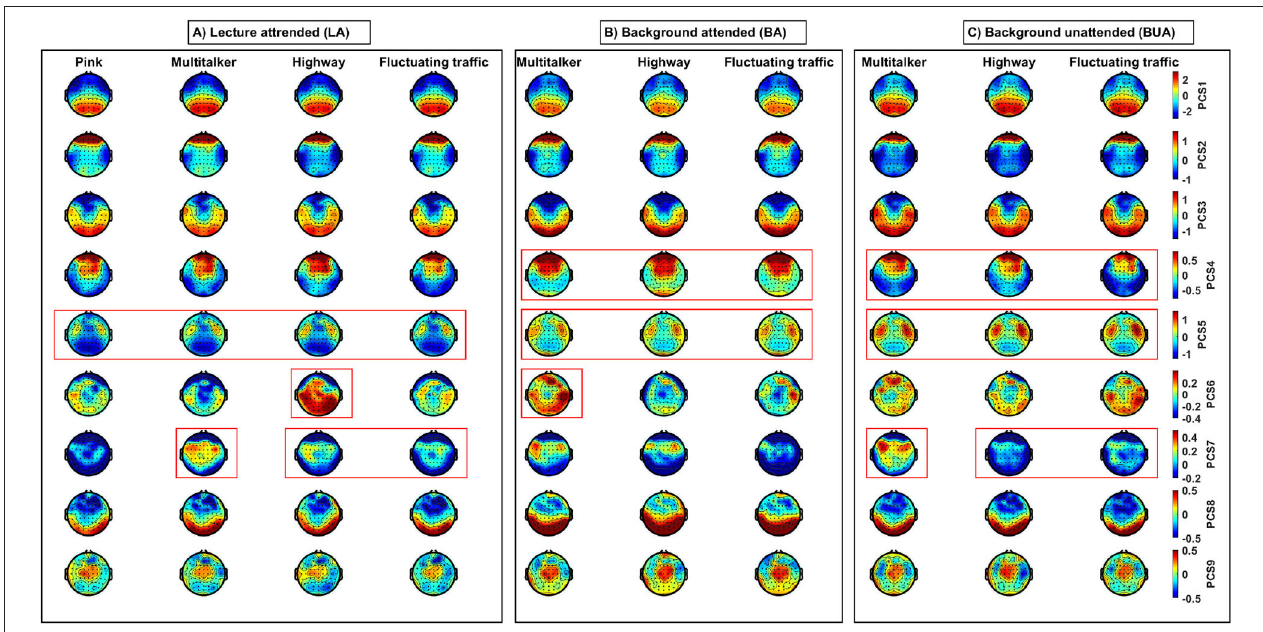
FIGURE 4 | Topographic maps of nine first EEG-PC scores ( PCS i,i = 1, ... ,9) of EEG-features (in rows) for three listening tasks (in three panels): (A) lecture attended (LA); (B) background attended (BA); and (C) background unattended (BUA) in different noises. Heads are in vertex view, nose is above, and left ear is on the left side. Each topographic map has been obtained by averaging EEG-PC scores across participants and fragments per listening condition and EEG channel. Each column belongs to one specific listening condition. The type of background noises is shown above the corresponding columns. The warm and cool color-coded areas represent the positively and negatively correlated cortical areas with the extracted components, respectively. Red frames show some spatial and activation differences suggesting the EEG-PC scores might contribute to statistical significance in the discrimination between the three listening tasks and the three background noises. Specifically, (i) PCS4 is higher in BA compared to BUA, (ii) PCS5 is the maximal and minimal in BUA and LA, respectively, (iii) PCS 6 is the maximal for highway in LA and multi-talker in BA, and (vi) PCS7 is the maximal for multi-talker in LA and